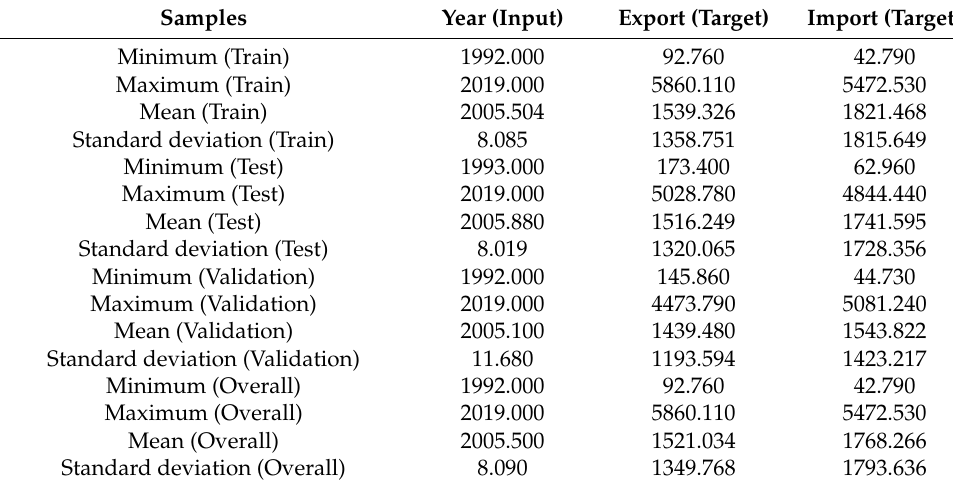
Table 1. Basic statistical characteristics of examined dataset.